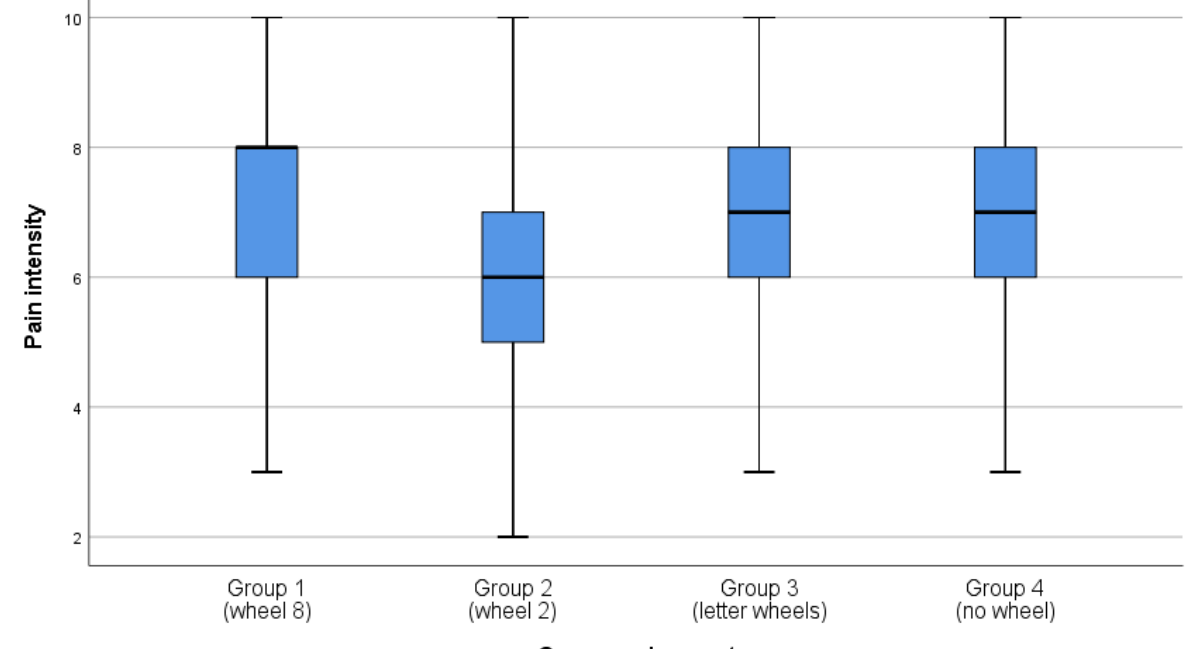
Figure 3. Boxplots of pain intensity ratings for groups 1-4.